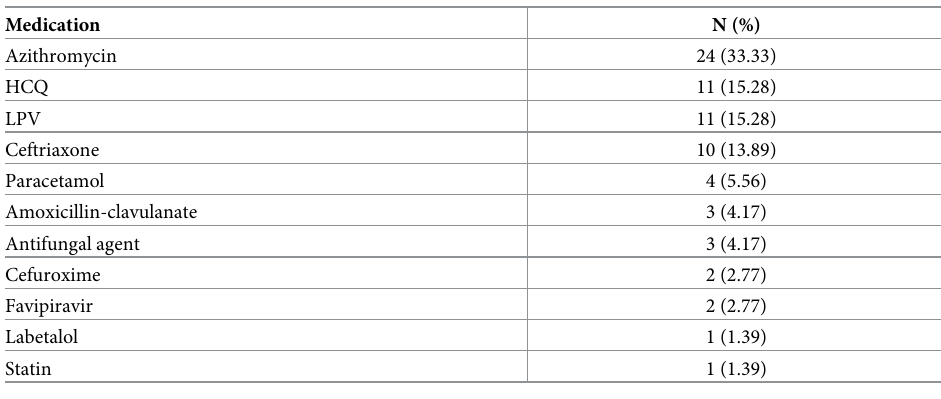
Table 2. The Distribution of DILI implicated medications.